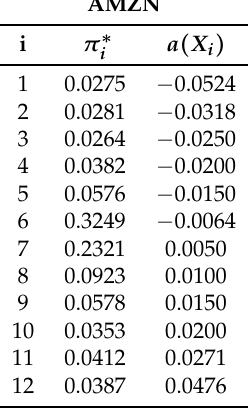
Table 7. Above, we have provided the state, associated ergodic probabilities and state values a ( i ) for AMZN, given a 12-state Markov chain that was obtained from choosing a 16 quantile method. AMZN i π ∗